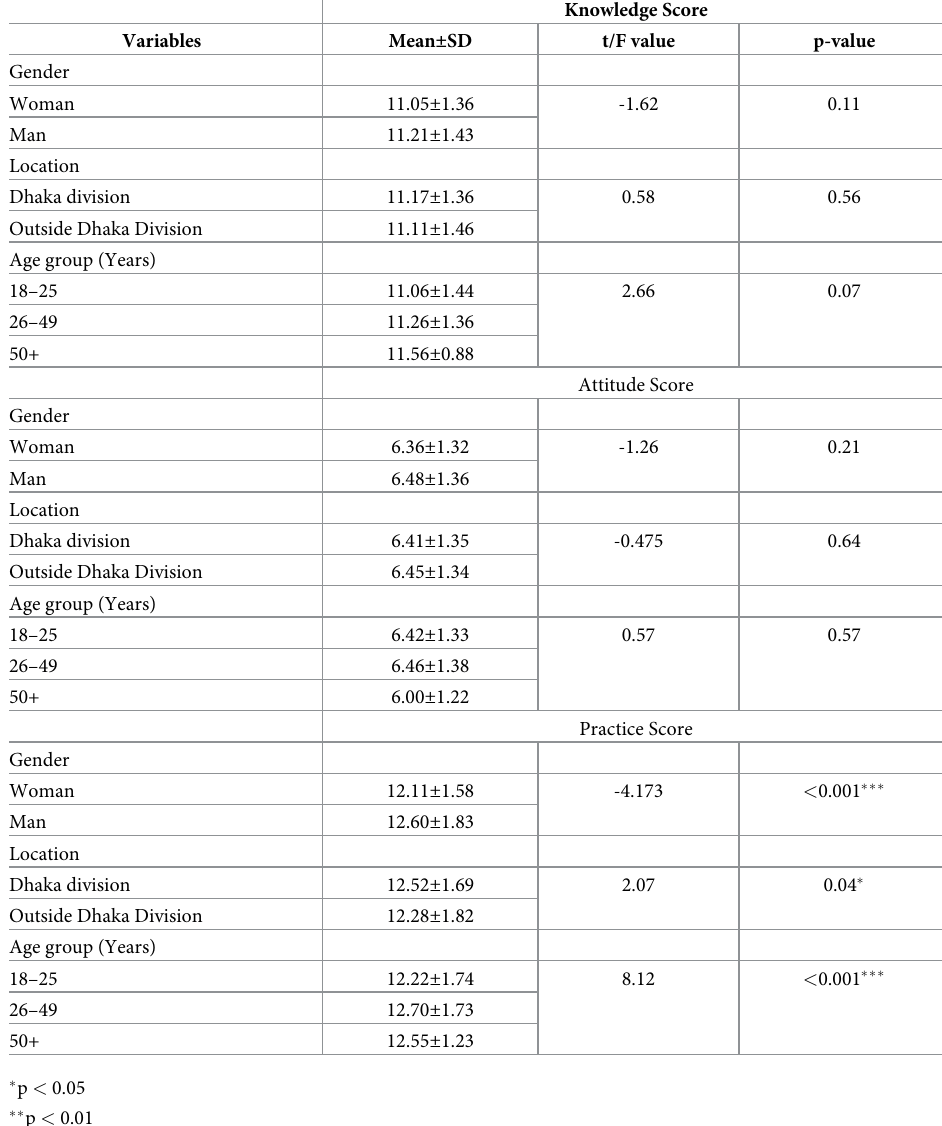
Table 2. Comparison of knowledge, attitude, and practice scores among different demographic